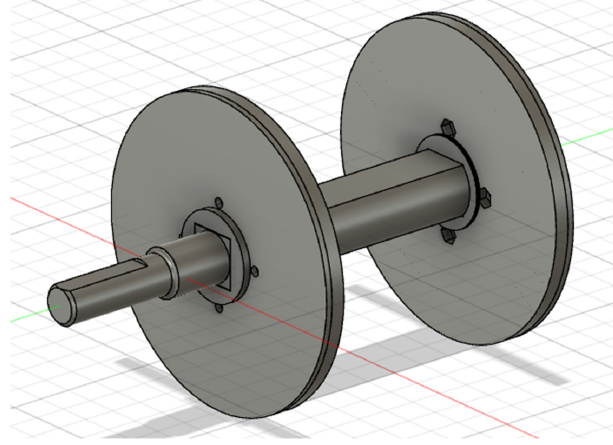
Figure 9. The stator of motor. The rotor is two discs rigidly mounted on the shaft with permanent magnets inside (Figures 10 and 11).